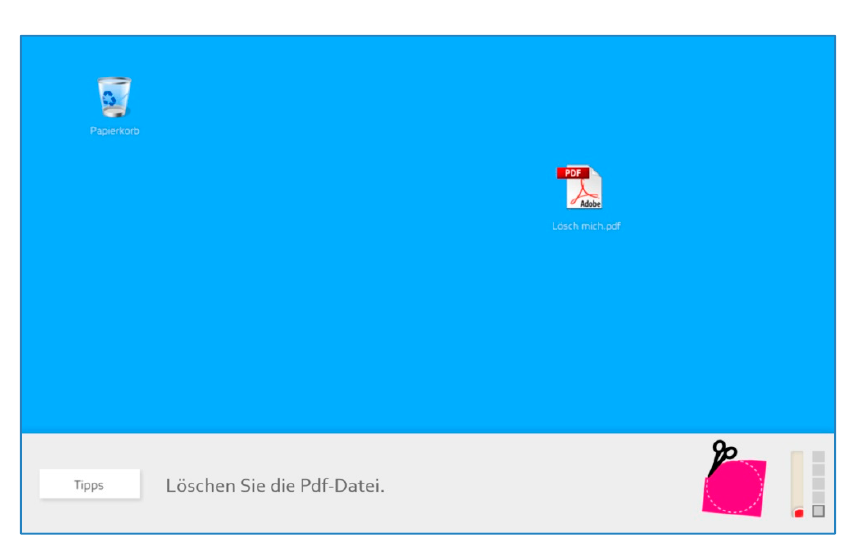
Figure 1. Screenshot of the gamified PC-Trainer used in the experiment. Participants should “delete the PDF file”. The help button is located at the lower left.